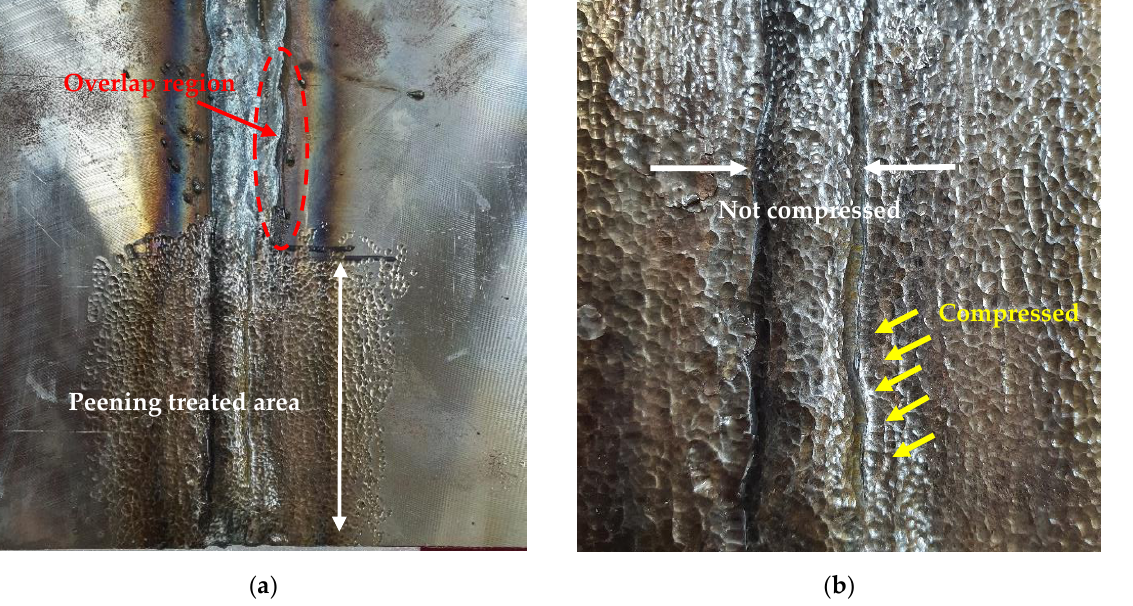
Figure 5. Photographs of overlap-defect weld after ultrasonic peening. ( a ) Peening surface of the overlap weld; ( b ) Close-up image of the peening area.